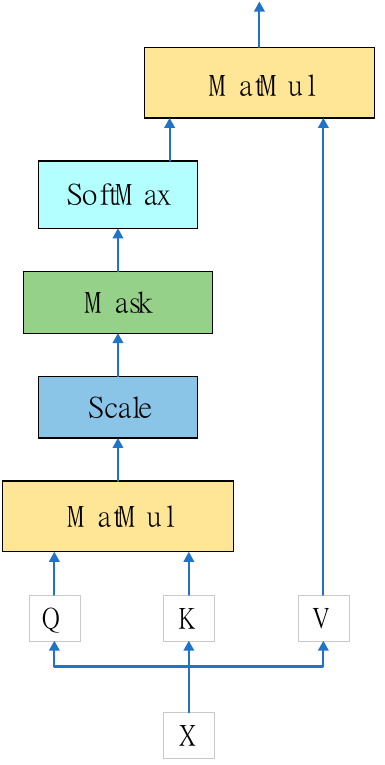
Figure 1. The scaled dot-product attention architecture.